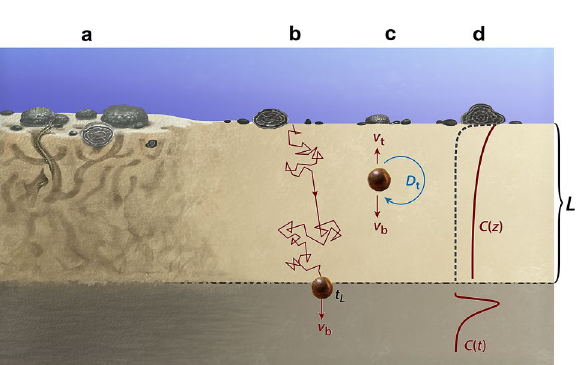
Figure 2. Particle transport within the SML. ( a ) Burrowing and reworking by benthic organisms. ( b ) Individual particles (e.g., a microtektite fragment) perform a biased random walk starting from the sediment surface, until disturbances cease below the SML. ( c ) Under certain conditions, the random walk in ( b ) is governed by a diffusion–advection equation, where the advective velocity is the sum of burial, bioadvective, and size segregation velocities. ( d ) Depth-dependent concentration C of tracer particles that are small enough to get buried (e.g., microtektite fragments, solid line) and of ferromanganese nodules large enough to stay indefinitely in the top part or the SML (dashed line). The curve below the SML indicates the microtektite distribution inside the historical layer resulting from an instantaneous deposition